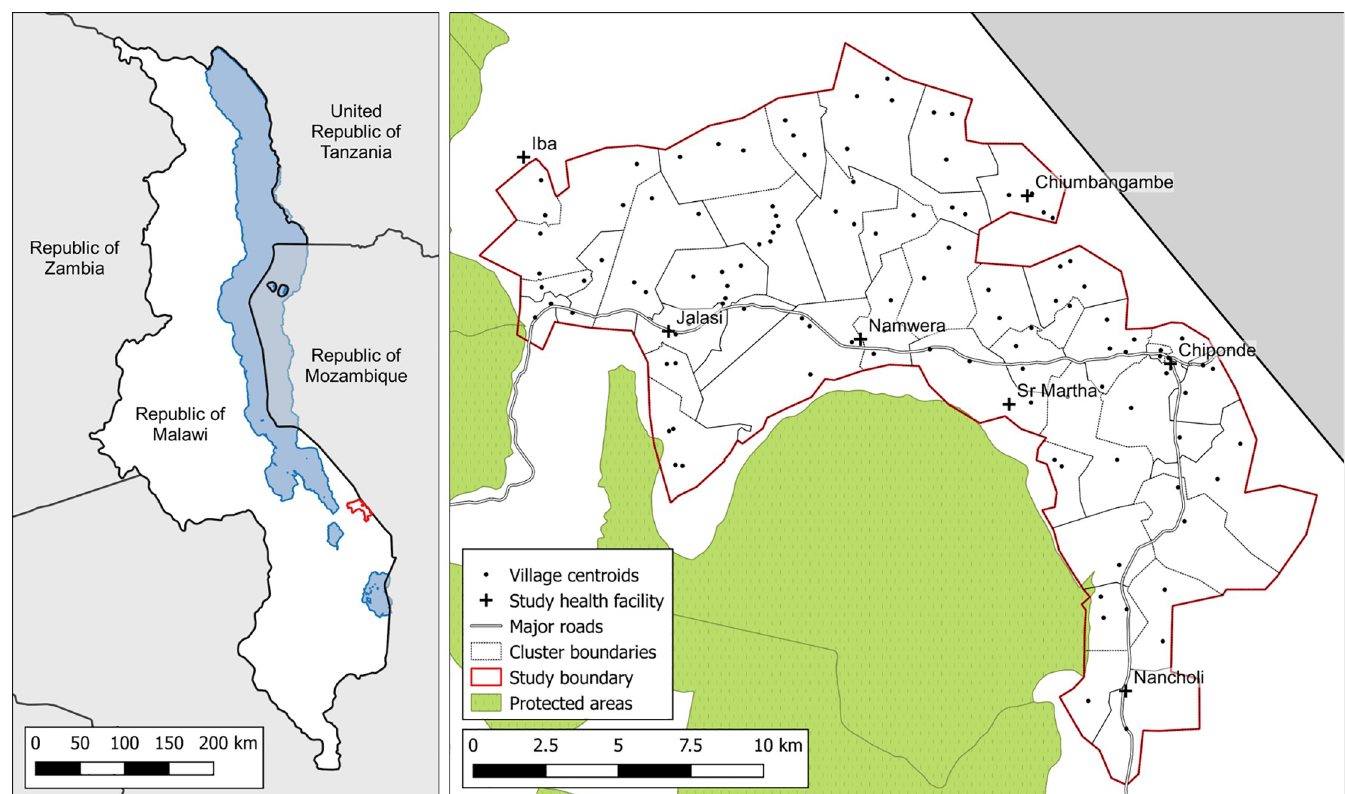
Fig 1. Location of study site within Malawi (left panel) and demarcated study clusters (right panel). Contains information from OpenStreetMap and OpenStreetMap Foundation, which is made available under the Open Database